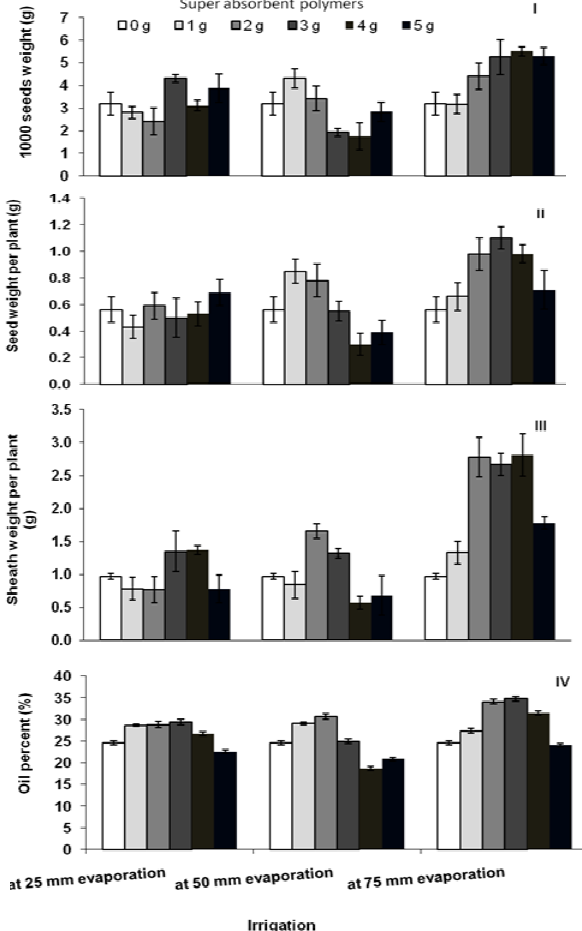
Fig. 4. Means comparisons of sheath on 1000 seeds weight (I), seed weight per plant (II), sheath weight per plant (III) and oil percent (IV) at different levels of super absorbent polymer and drought